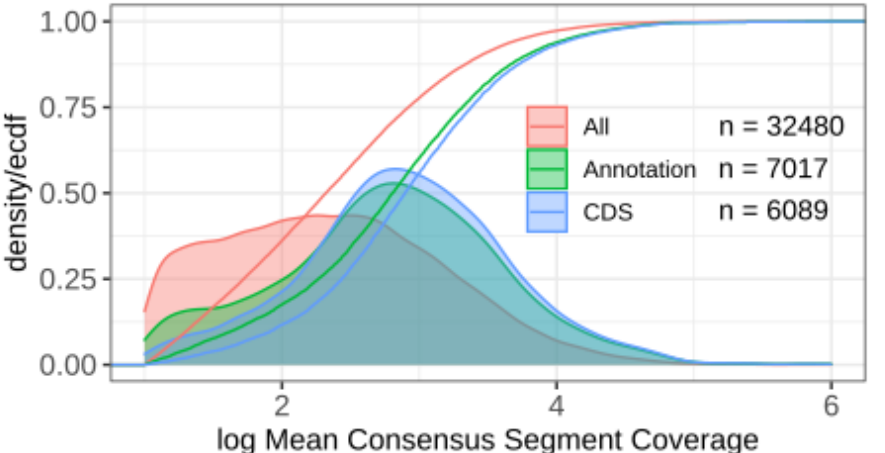
Figure 5. Distribution of RNA expression across the consensus segmentation of S. cerevisae IFO 0233. We distinguish segments that overlap a coding sequence (CDS) or another annotation item (Annotation) present in the current genome annotation taken from SGD (Saccharomyces Genome Database), and unannotated segments (All). An overlap of at least 30% with an annotation item was required. Densities are normalized to 1 for each class. Cumulative distributions are